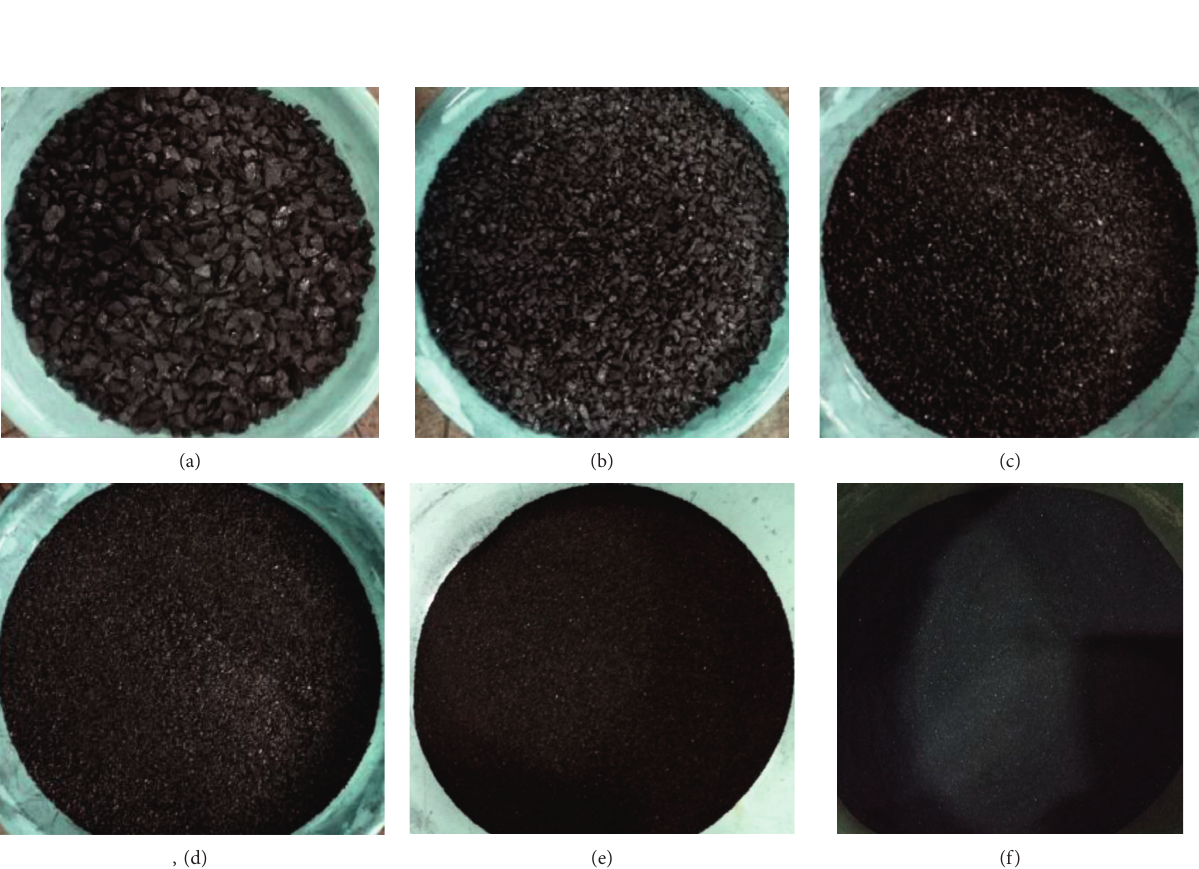
Figure 4: Screening coal samples with different particle sizes: (a) 10 ≤ d ≤ 15mm coal sample, (b) 6 ≤ d ≤ 10mm coal sample,